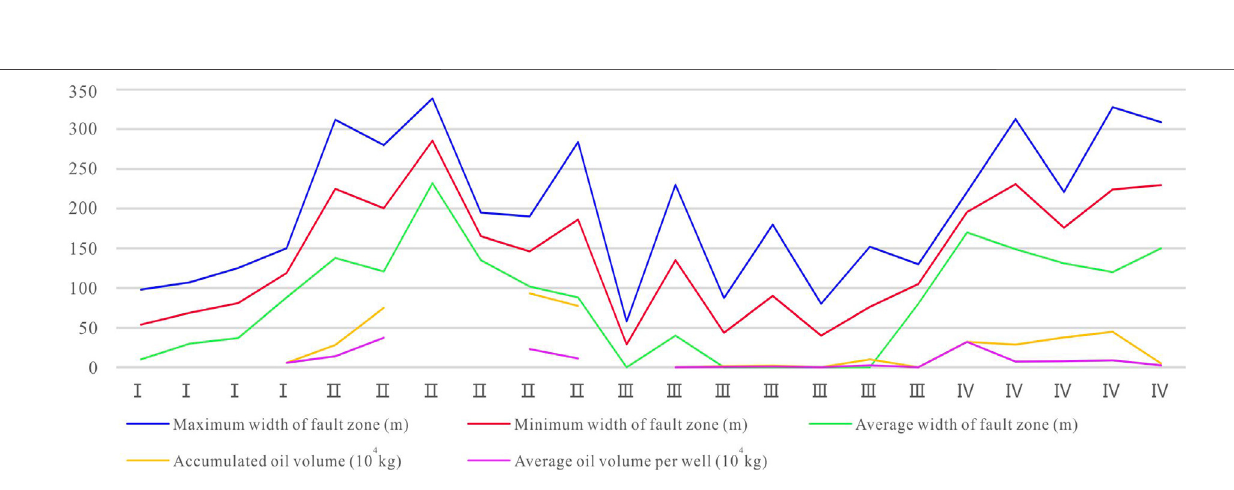
Frontiers in Earth Science |